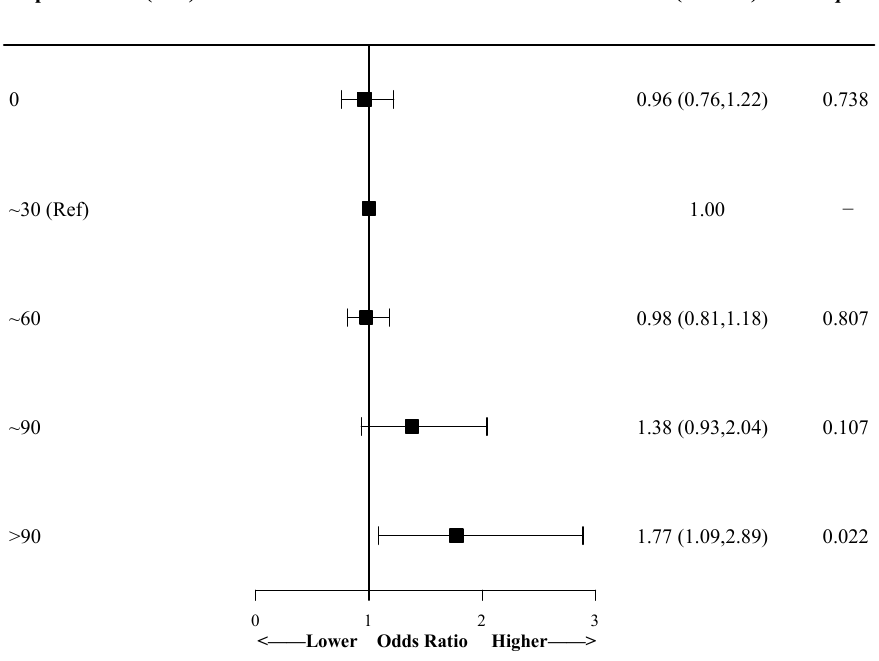
Figure 1. The association between nap duration and prevalence of metabolic syndrome by logistic regression model. Model was adjusted for demographic factors, lifestyle habits, mood symptoms, and sleep-related characteristics. Small squares represent the point estimates of odds ratios, and horizontal lines represent 95% CIs. OR, odds ratio; CI, confidence interval; Ref, reference.